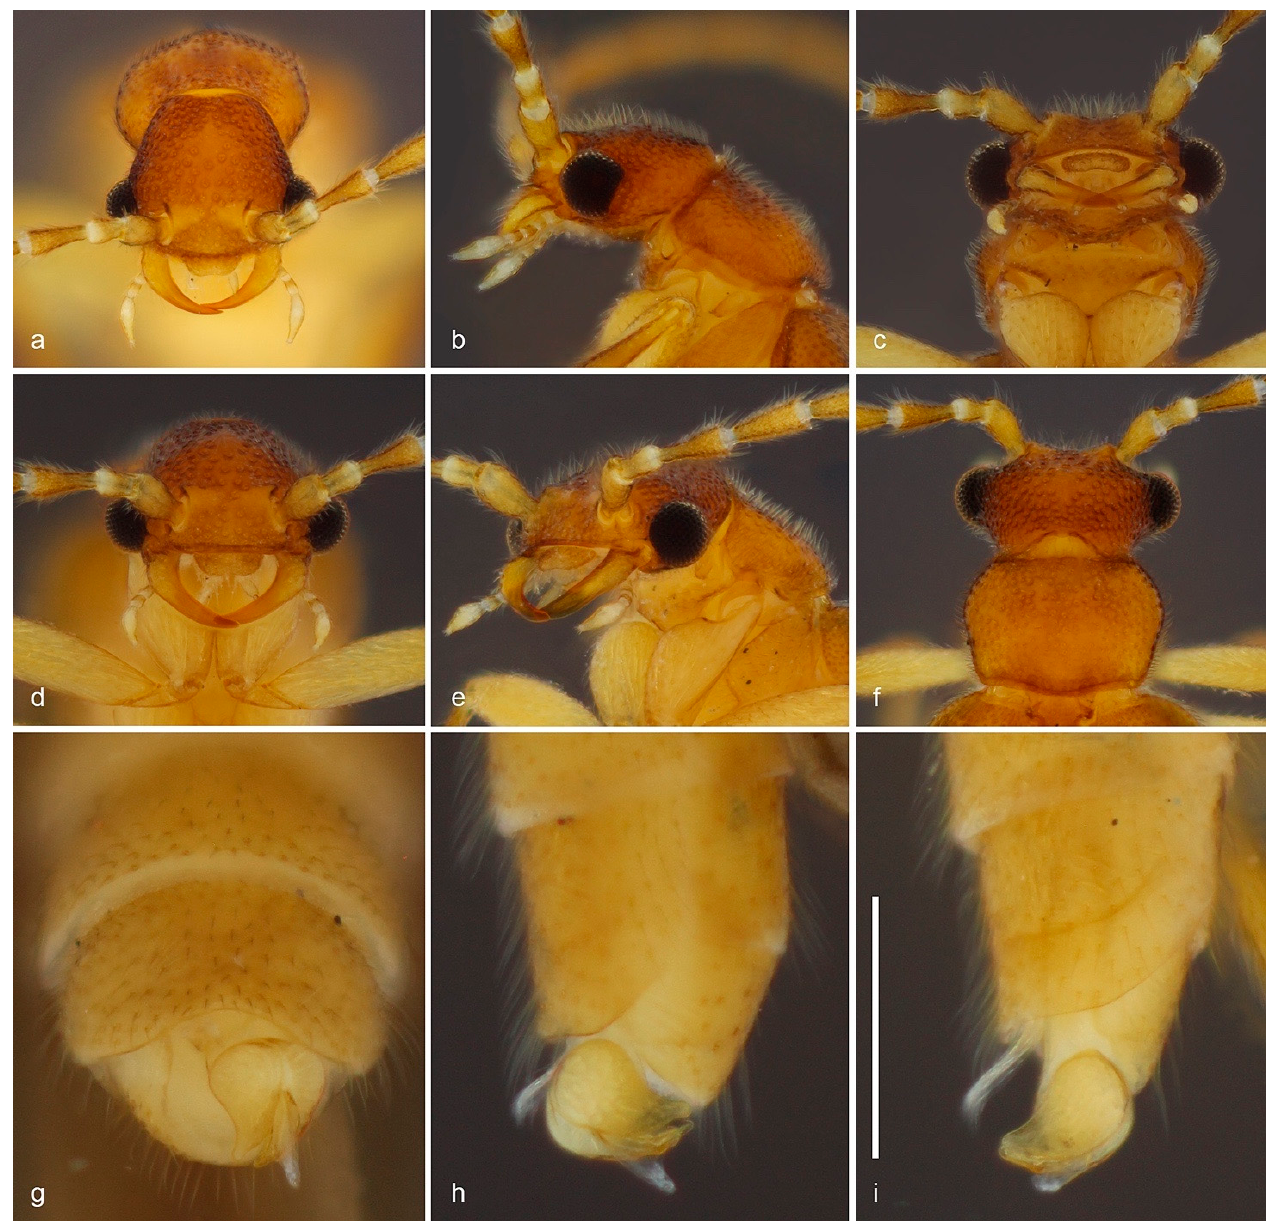
Figure 6. Jurasai digitusdei Rosa, Costa, Kramp and Kundrata, 2020, specimen from Núcleo Santa Virgínia, São Paulo state, details of morphology. ( a ) Head, anterodorsal view; ( b ) head and prothorax, lateral view; ( c ) head and prothorax, ventral view; ( d ) head, frontal view; ( e ) head and prothorax, frontolateral view; ( f ) head and pronotum, dorsal view; ( g – i ) abdominal segments VII–IX, parameres and phallus: ( g ) ventral view (with aedeagus approximately 160° rotated); ( h ) lateral view (with aedeagus approximately 160° rotated); ( i ) ventrolateral view. Scale bars = 0.5 mm.